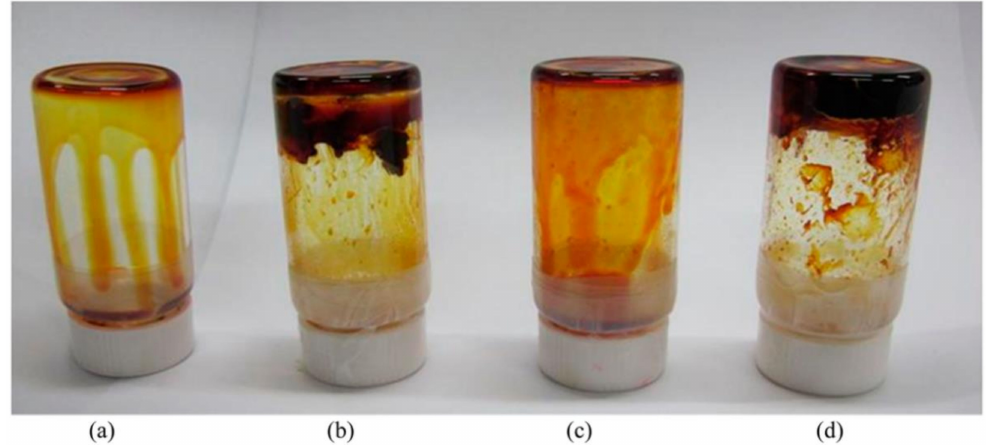
Figure 7. Upside-down vessel containing the PMII / I 2 / PEGDME electrolyte with ( a ) none, ( b ) 9 wt % of fumed silica, ( c ) 9 wt % of silica rods, and ( d )12 wt % of silica rods, respectively (reproduced from Reference [132] with permission, copyright American Chemical Society,